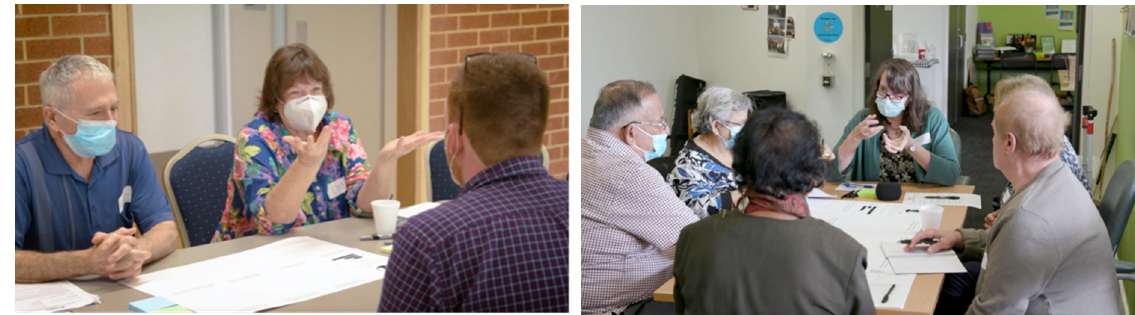
Figure 5. Workshops at the Wollert ( left ) and Thomastown ( right ) locations.